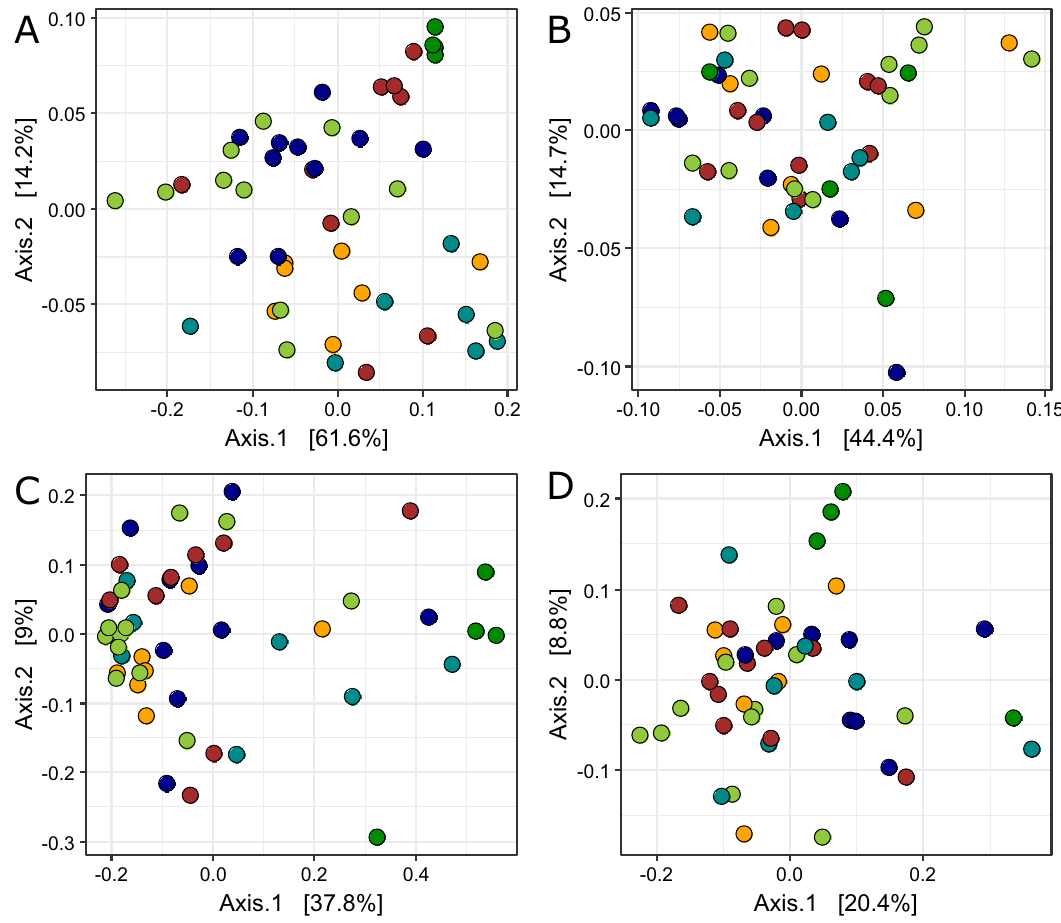
Figure 3. Non-metric multidimensional scaling ordination of bacterial ( A , C ) and archaeal ( B , D ) 16S rRNA profiles using weighted ( A , B ) and unweighted ( C , D ) UniFrac distance metrics. Colour is indicative of the sample type from which the community was sampled: orange , amniotic fluid; light green , ruminal fluid; dark green , ruminal tissue; cyan , caecal fluid; blue , caecal tissue; red , meconium. Two-dimension stress ranged from 0.06 to